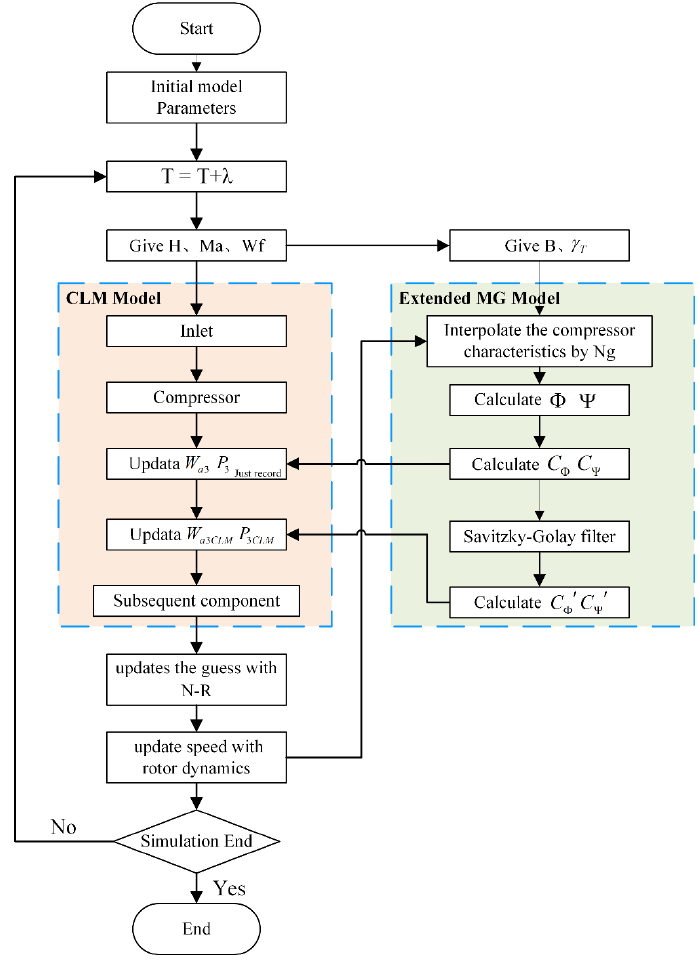
Figure 9. Dynamic calculation of real-time surge model of turboshaft engine.